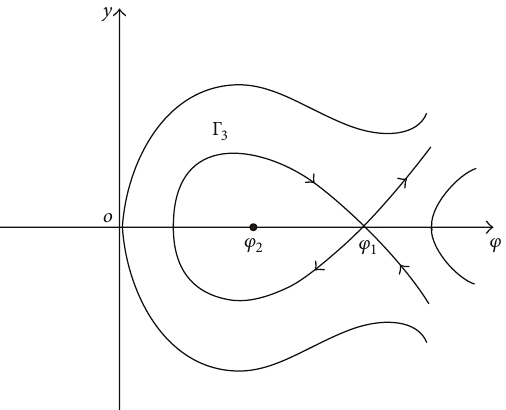
Figure 13: The graph of orbit Γ 3 when 𝛿 > 0 and (𝑎,𝑏) ∈ 𝐴 3